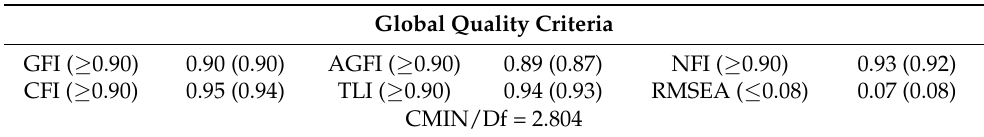
Table 6. Checking the reliability and validity of the tests.